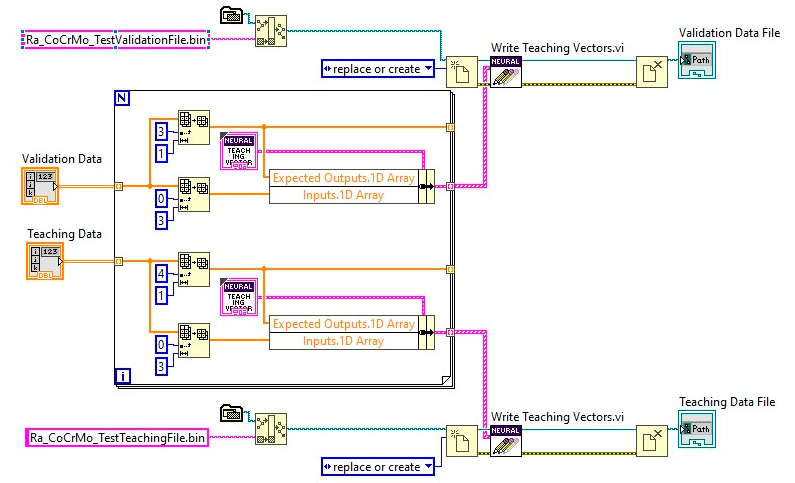
Figure 9. Partial diagram of application software for preparing the teaching and validation data files of an ANN.